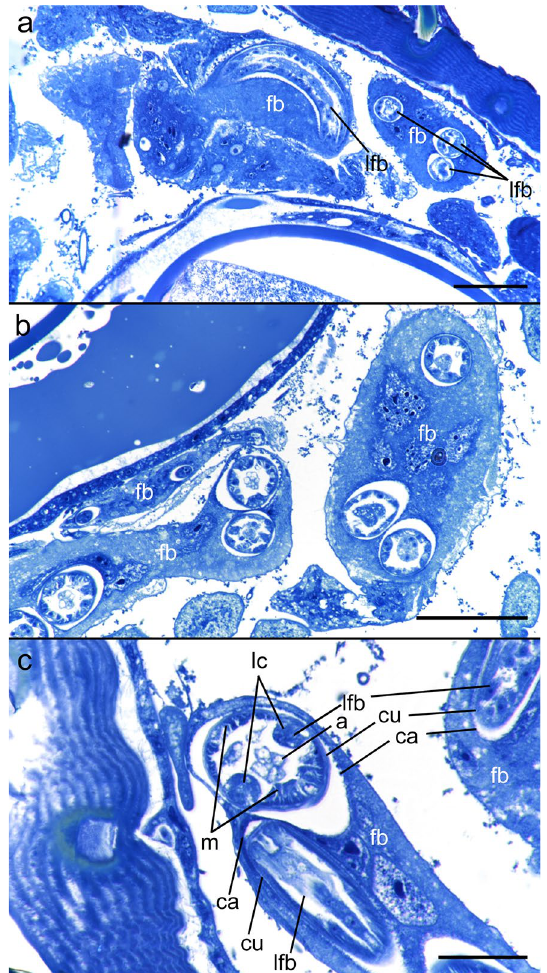
Figure 6. Histological cross-sections showing multiple Acanthocheilonema spirocauda larvae encapsulated in fat bodies. Scale bars: ( a , b ) 50 µm, ( c ) 20 µm. Abbreviations: a = nematode alimentary tract, ca = capsule, cu = nematode cuticle, fb = fat body, lc = nematode lateral chords, lfb = larvae contorted in the fat body, m = nematode